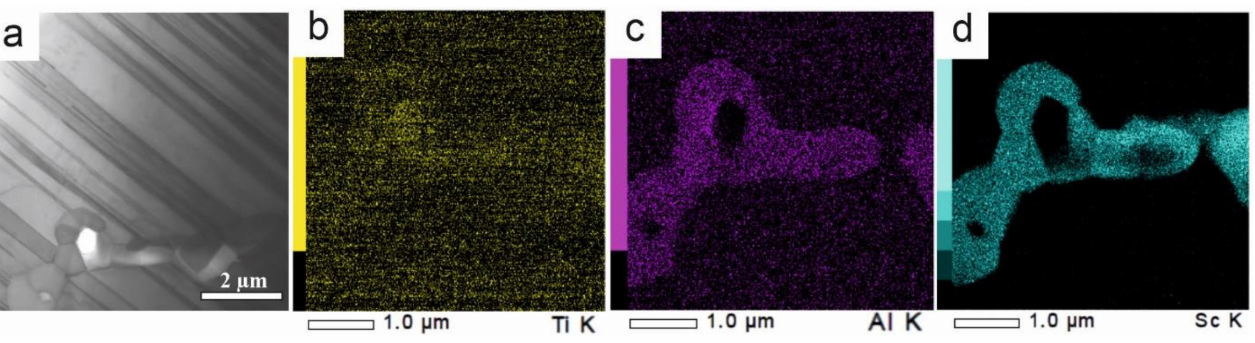
Figure 6. TEM images of the Ti-Al-Sc alloy ( a ) and super-spectral alloy ( b – d ). Figure 7a presents a bright-field image of the Ti-Al-Sc alloy with a lamellar structure. There are both wide and narrow layers, differing by the phase composition. To identify them in more detail, the microdiffraction pattern has been interpreted (Figure 8a). The dark-field images have been